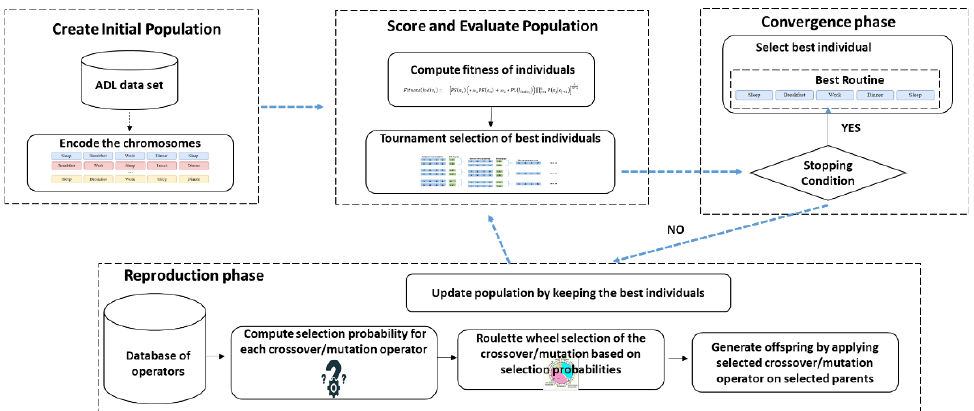
Figure 1. Genetic solution for routine detection.